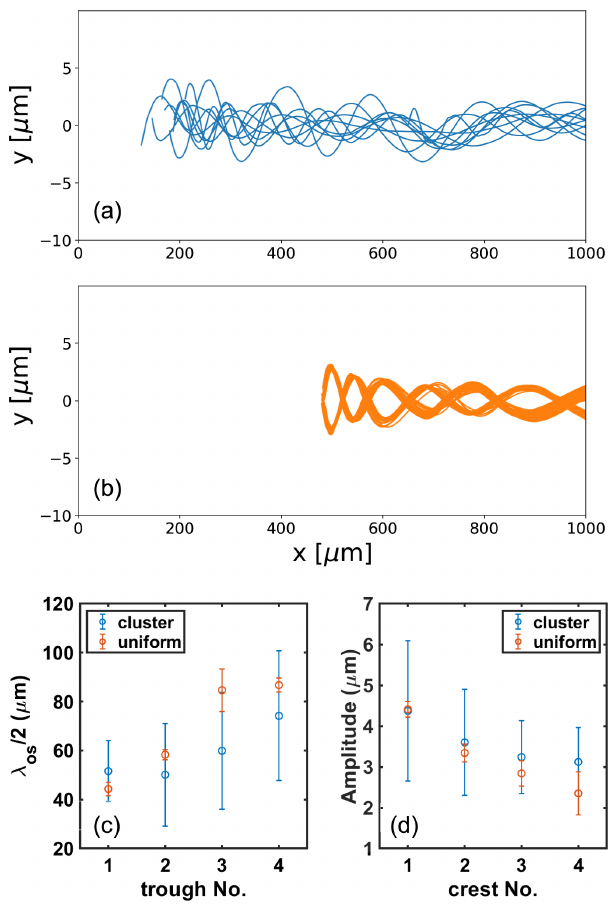
FIG. 5. This figure presents particle trajectories of trapped electrons from the point of injection into the wake for the cluster (a) and uniform (b) case. Out of 100 trajectories, 10 tracks were randomly chosen and analyzed (c,d). Half-wavelength distances and oscillation amplitude are plotted against the troughs (and crests) of the electron trajectory. The error bars correspond to the standard deviation ( 1 σ ) obtained from the 10 randomly chosen